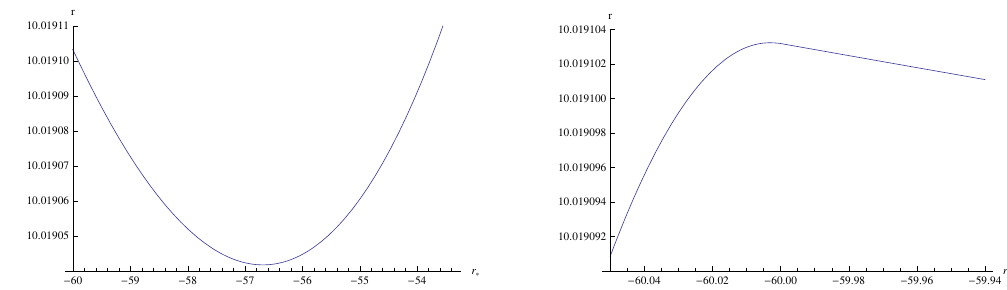
Figure 6 . Magni(cid:12)ed view of the plot of r vs. r (cid:3) around r (cid:3) = a (cid:3) ’ (cid:0) 56 : 685 (left) and that around r (cid:3) ’ r (cid:3) s (right) of (cid:12)gure 4. Note that r ( r (cid:3) ) is in fact a decreasing function between